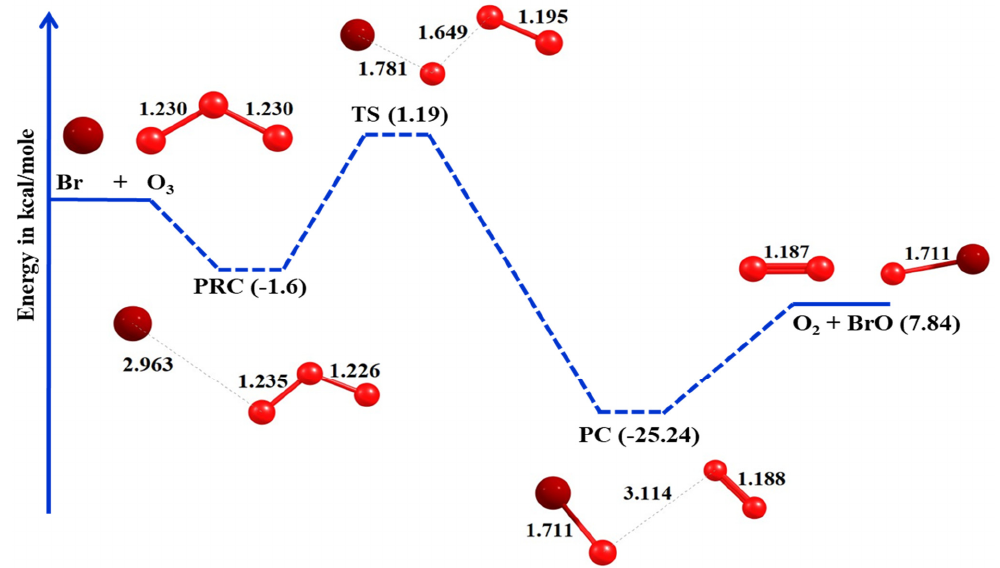
Figure 3. Potential energy level diagram for the reaction of O 3 with Br obtained at the MRCI + Q/aug-ano-RCC- VTZP//MP2/aug-cc-pV(T + d)Z levels of theory. Table 4. The obtained bond lengths (r e in Å) and bond angles ( θ in deg) for the reaction of Br + O 3 at various levels of